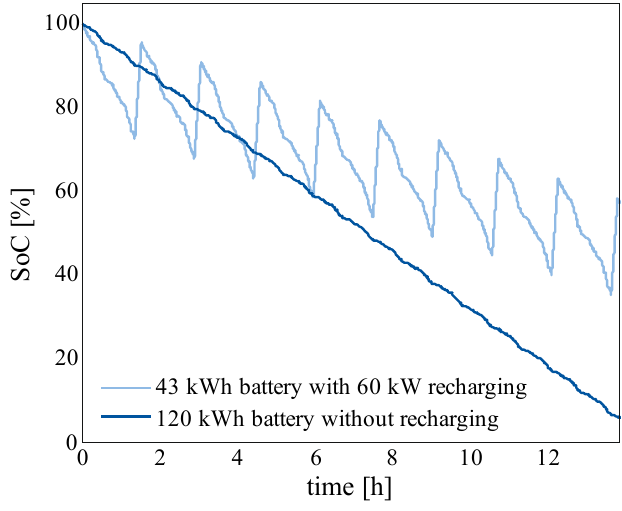
Figure 5. Comparison of operation without recharging and recharging with a depleting SoC during